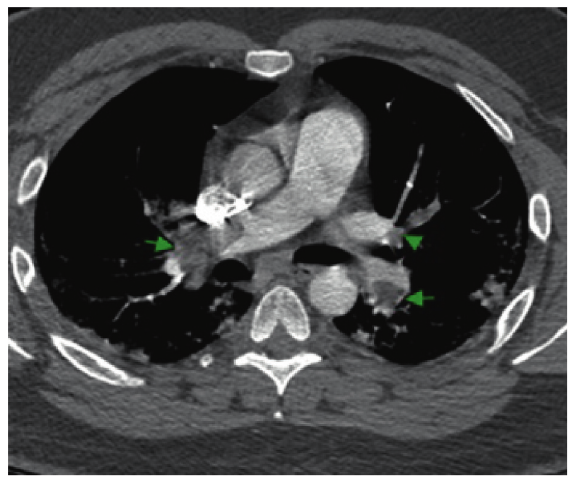
Figure 2: Chest axial CT image on a vascular window shows extensive bilateral multifocal acute pulmonary embolism (green arrows) without any radiological evidence of right heart